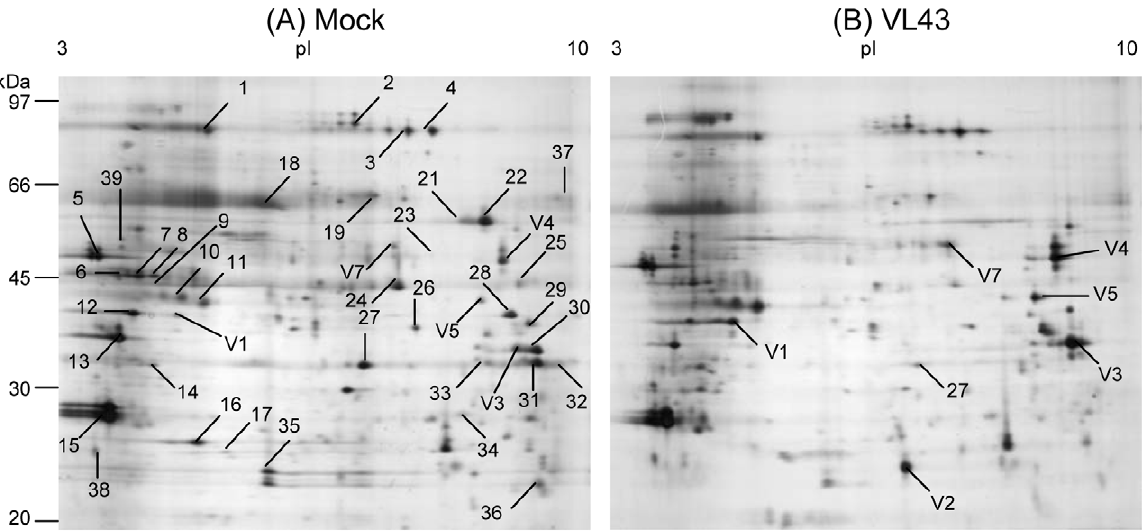
Figure 1. Typical 2-D gels showing Arabidopsisthaliana apoplastic leaf proteins after mock (A) or Verticilliumlongisporum (VL43) infection (B). Proteins were extracted 25 dpi and 80 m g were loaded for separation. Gels were stained with silver nitrate. Numbers in the gels indicate protein spots analyzed by ESI-LC/MS from preparative Coomassie-stained gels.